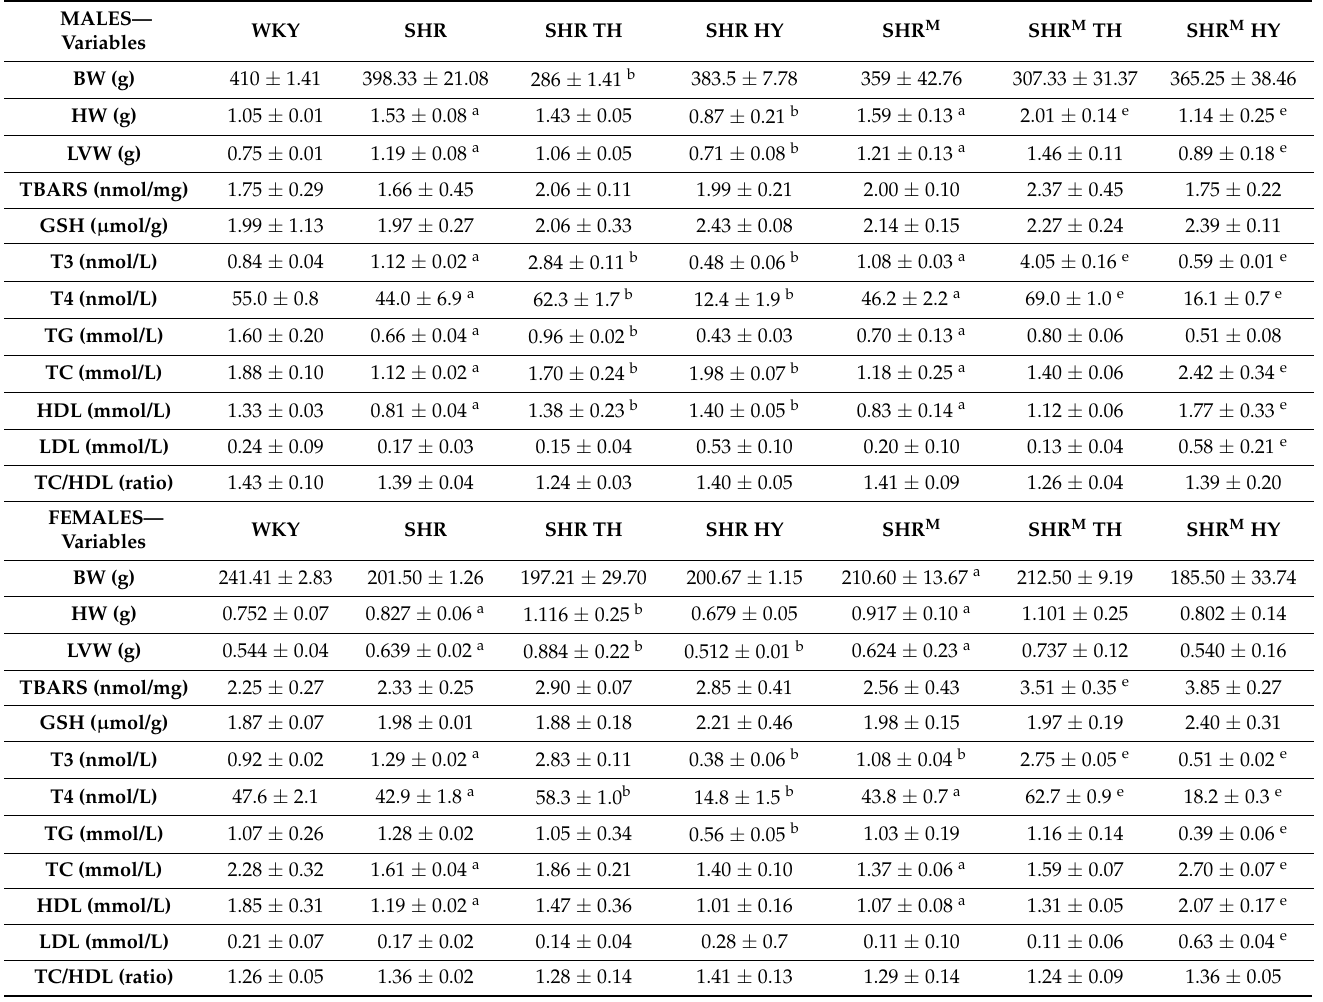
Table 2. General characteristics of the experimental